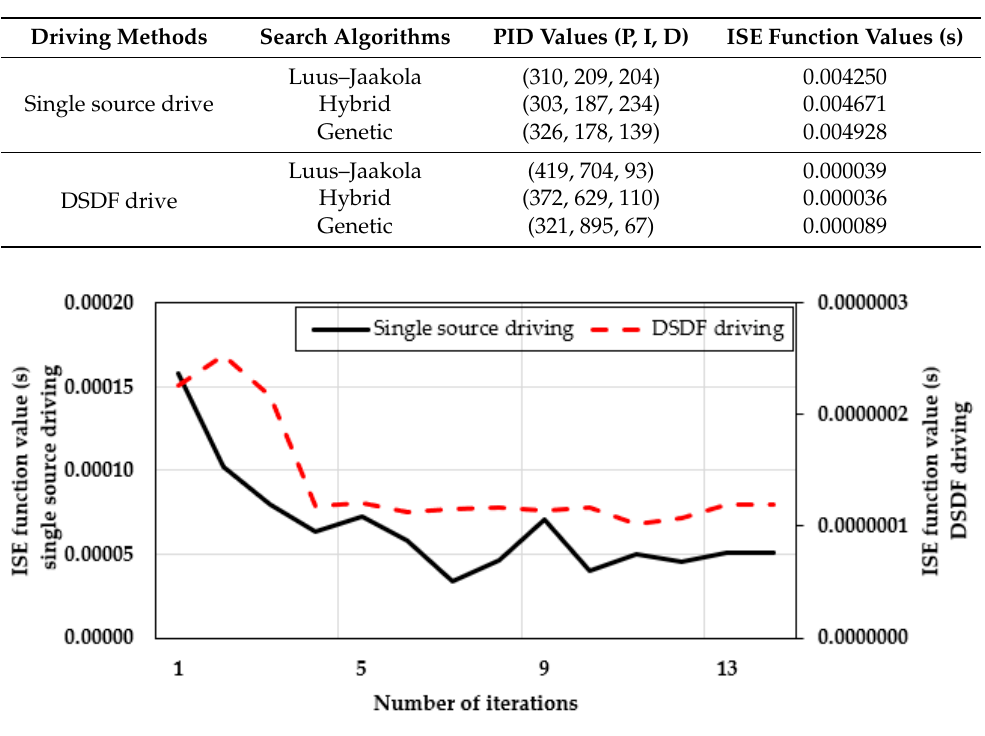
Figure 16. Convergence curve comparison at velocity 1.0 °/s.